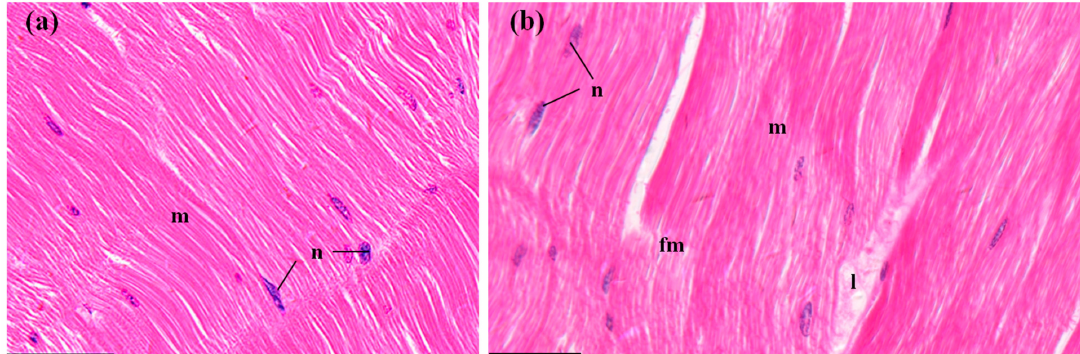
Figure 7. The muscles of P. clarkii after 96 h exposure to: A control solution and 72.62 mg/L MBA. ( a ) Control muscles with ordered myofibers (m) and oval nuclei (n) (400 × ). ( b ) Damaged muscles exhibited slight fracture (fm) and lysis (l) of some myofibers (400 × ). m, myofiber; n, nucleus. H&E stain, scale bars = 100 µ